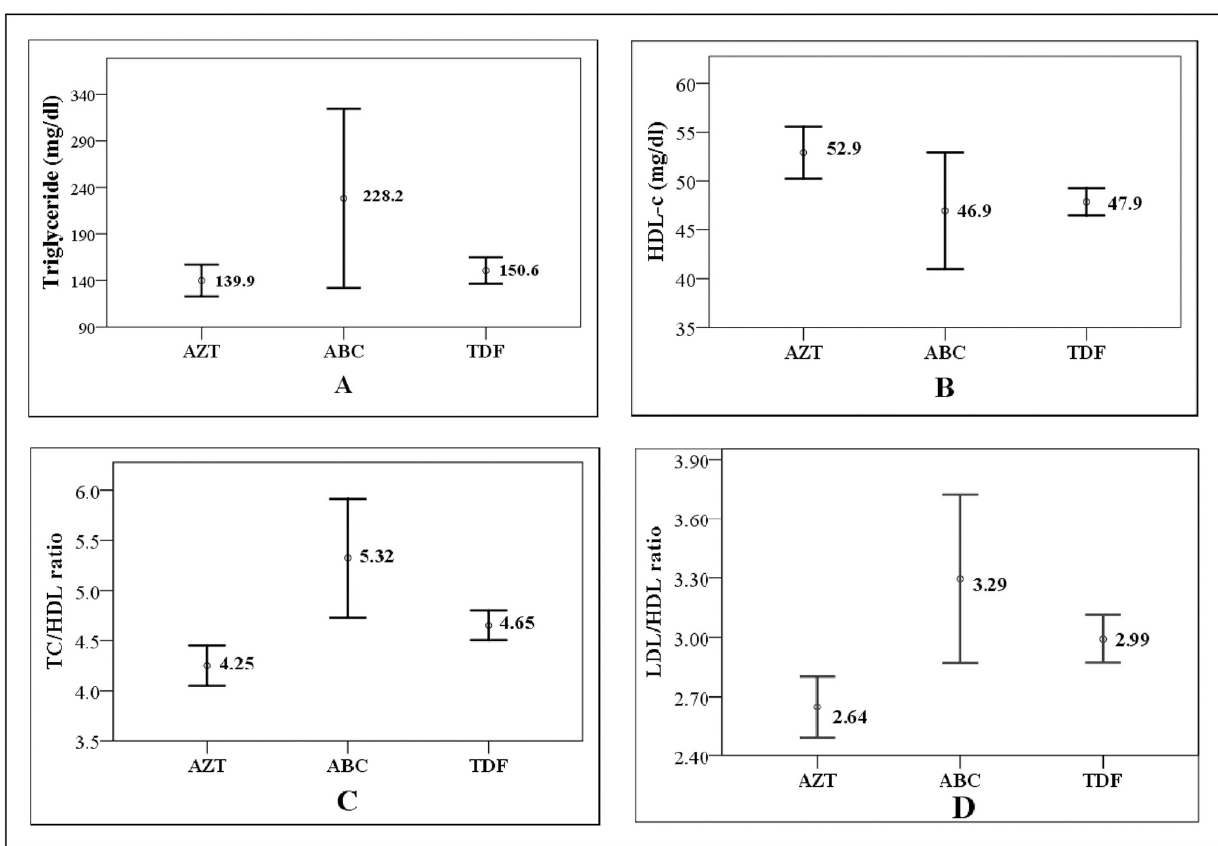
Fig 1. A-D: Schematic representation of lipid parameters and HAART regimen. Indicated are lipid parameters with significant differences among HAART regimen (p < 0.05). The data are exhibited as mean ± CI 95% after one-way ANOVA analysis. AZT: zidovudine; ABC: abacavir; TDF: tenofovir; CI: confidence